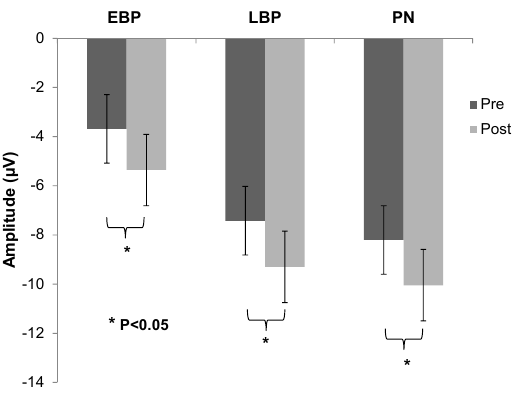
Figure 3. Group mean (±SE) of the early bereitschafts-potential (EBP), late bereitschafts potential (LBP) and Peak negativity (PN) amplitudes in the pre (black bars) versus post-spinal manipulation session (grey bars).